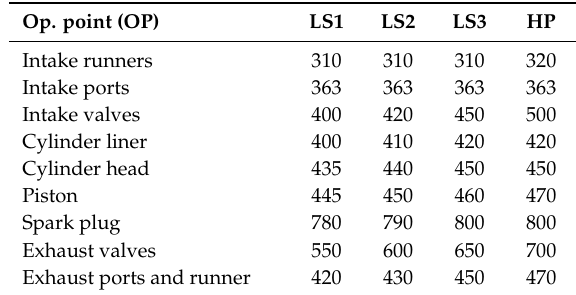
Table A3. Assumed wall temperatures in K for the different simulated operating points.